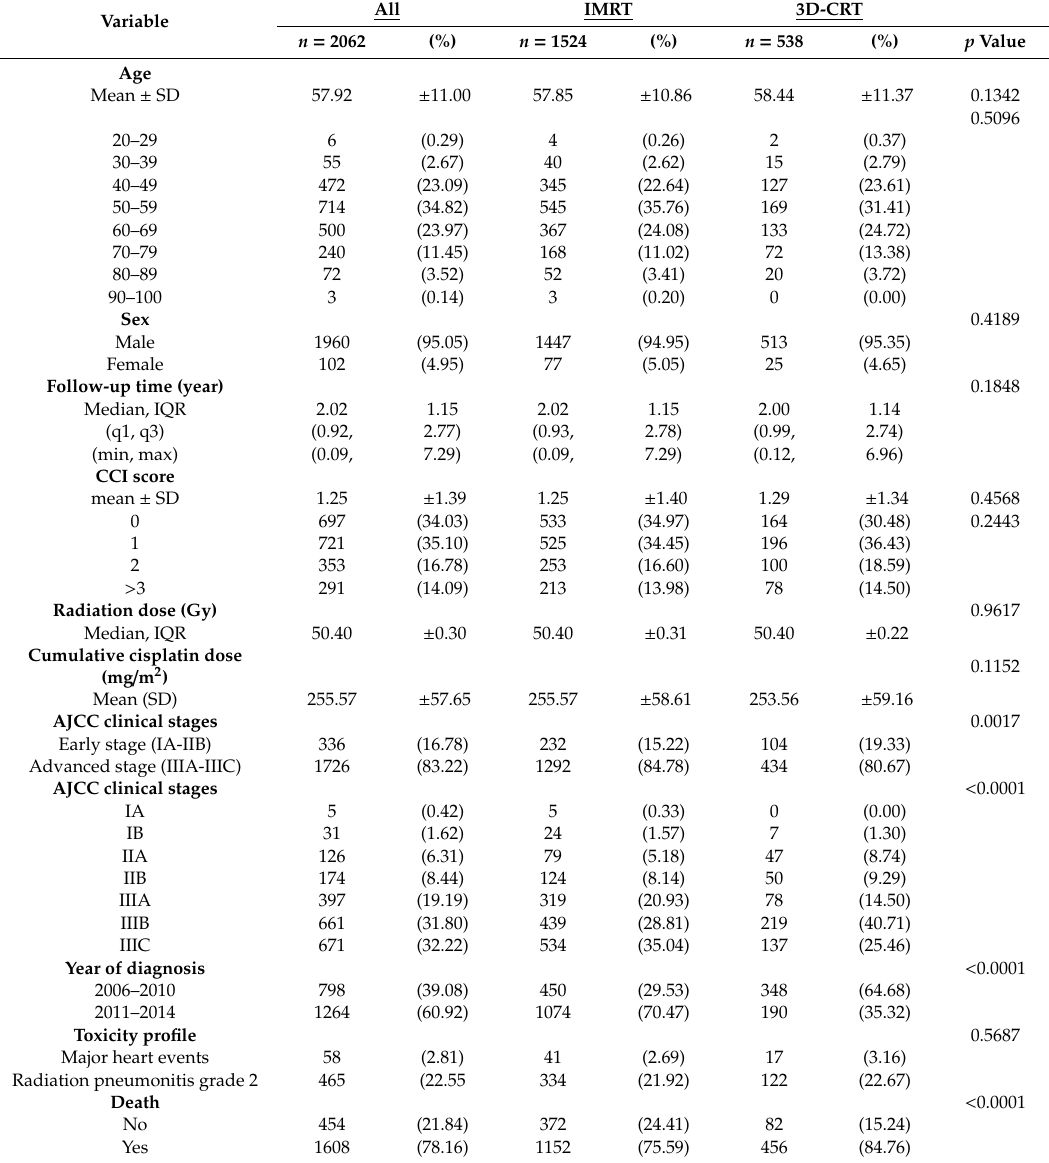
Table 1. Characteristics of patients with thoracic esophageal squamous cell carcinoma (TESCC) receiving concurrent chemoradiotherapy (CCRT) with intensity-modulated radiation therapy (IMRT) or 3D-CRT (conformal radiation